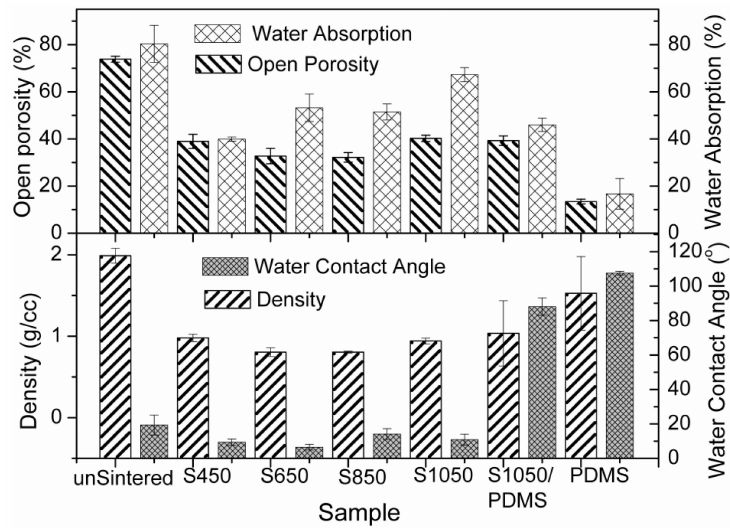
Figure 6. Density, open porosity, water absorption and water contact angle (WCA) of unsintered; S450, S650, S850, and S1050 ceramics samples; and S1050/PDMS composite